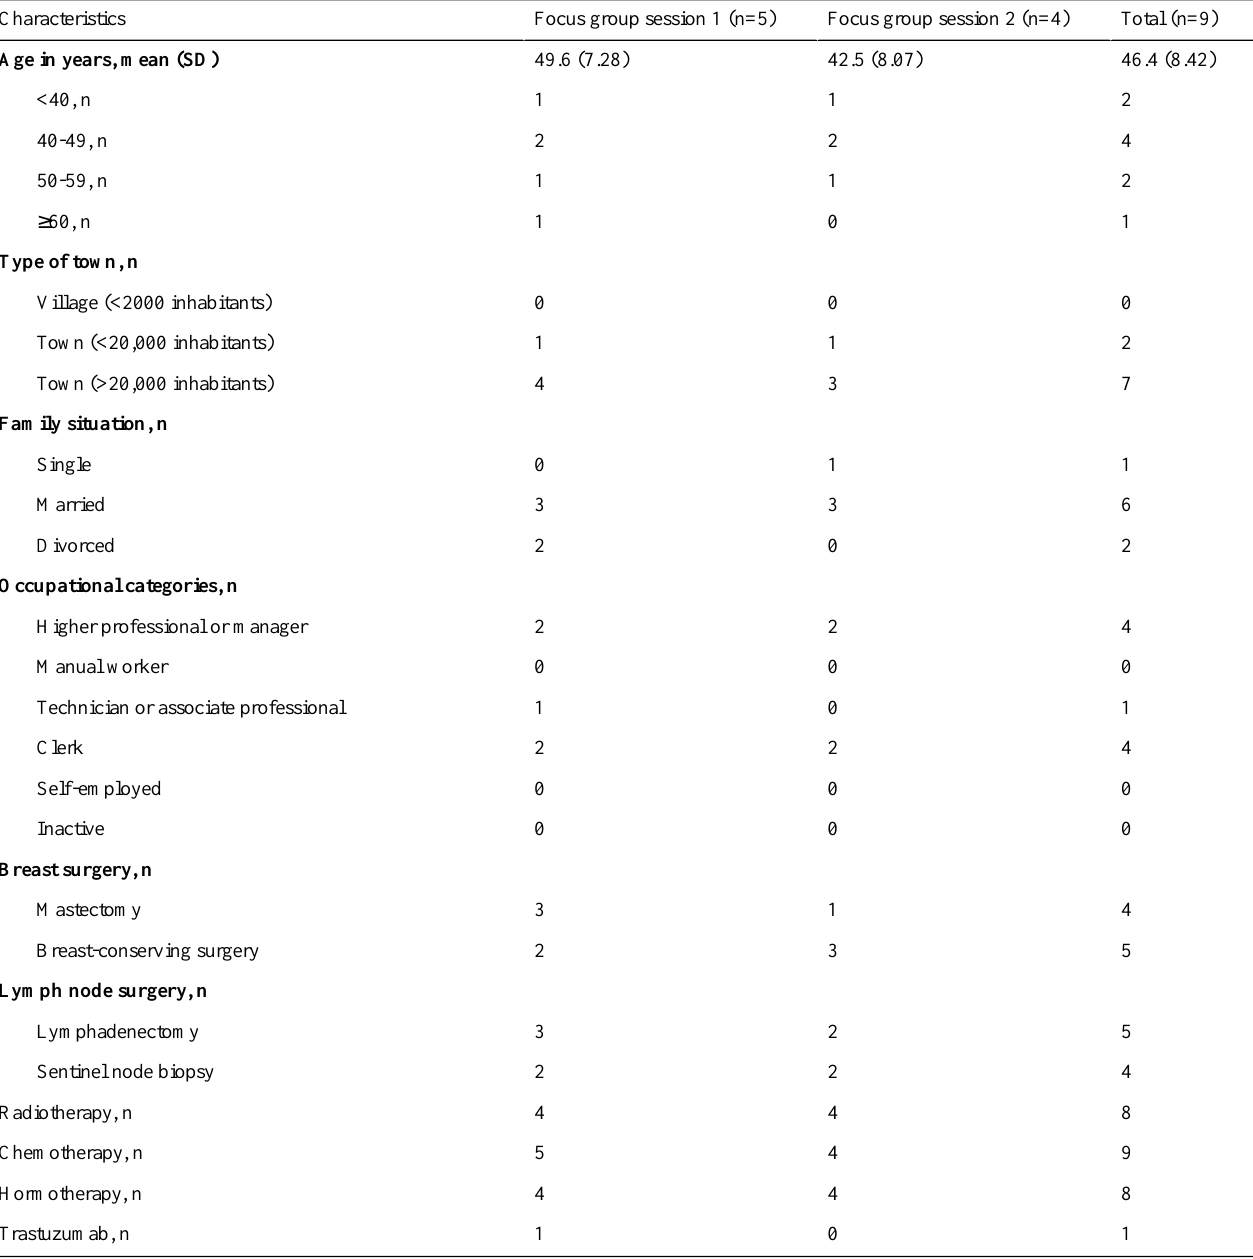
Table 1. Characteristics of the